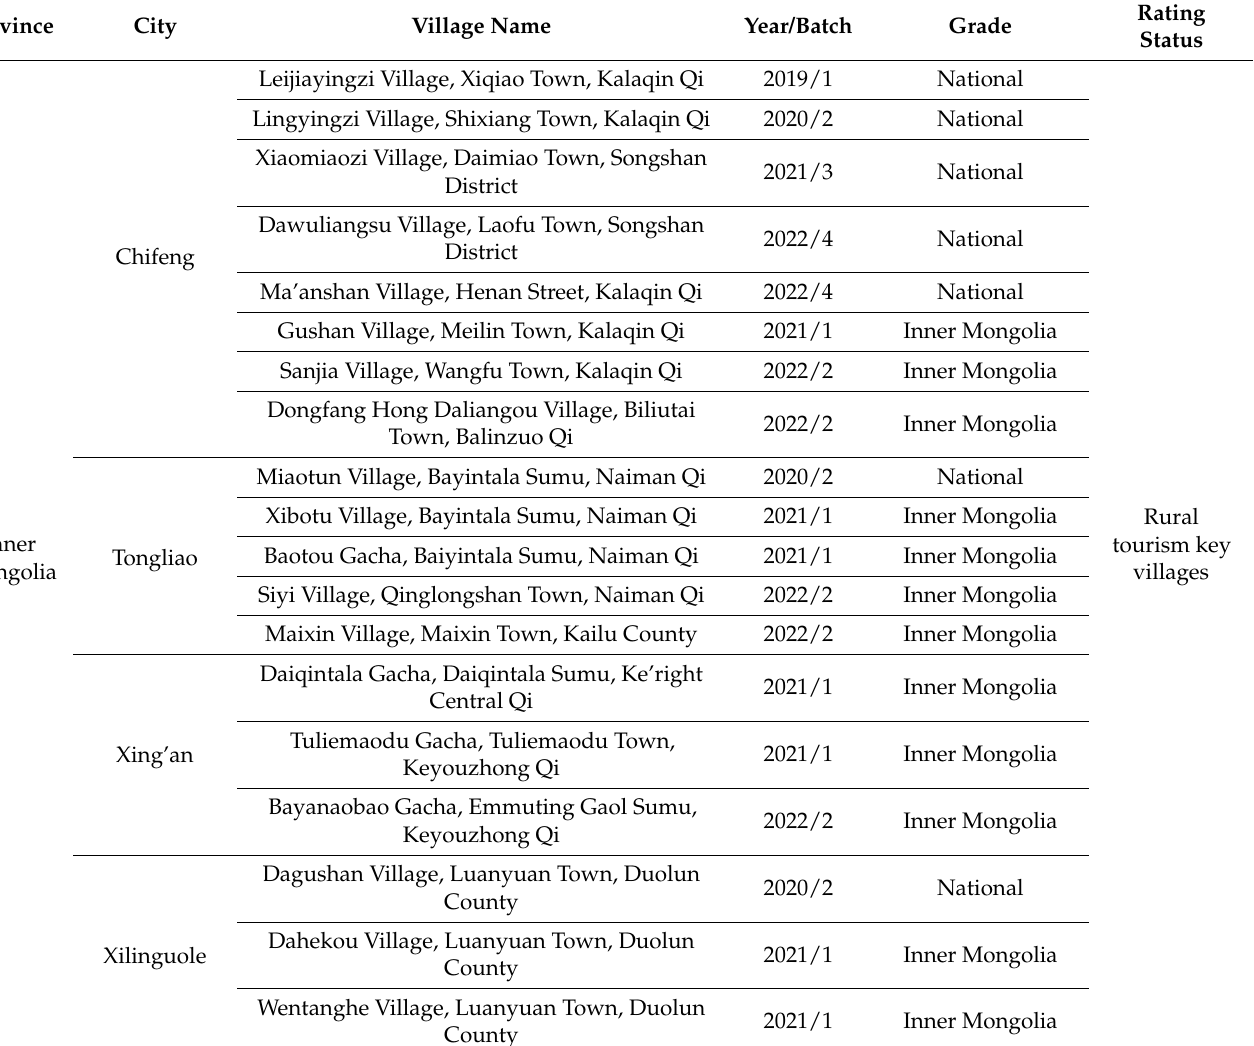
Table 1. List of key villages for rural tourism in different batches and grades in the Western Liao River Basin, Inner Mongolia,